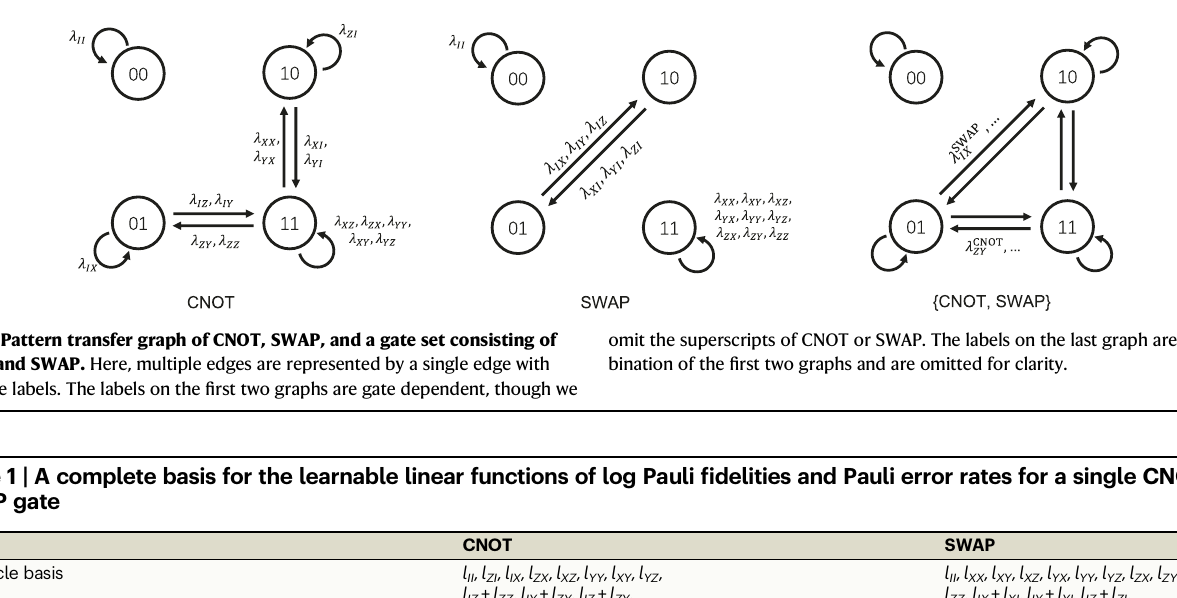
Table 1 | A complete basis for the learnable linear functions of log Pauli fi delities and Pauli error rates for a single CNOT/ SWAP gate